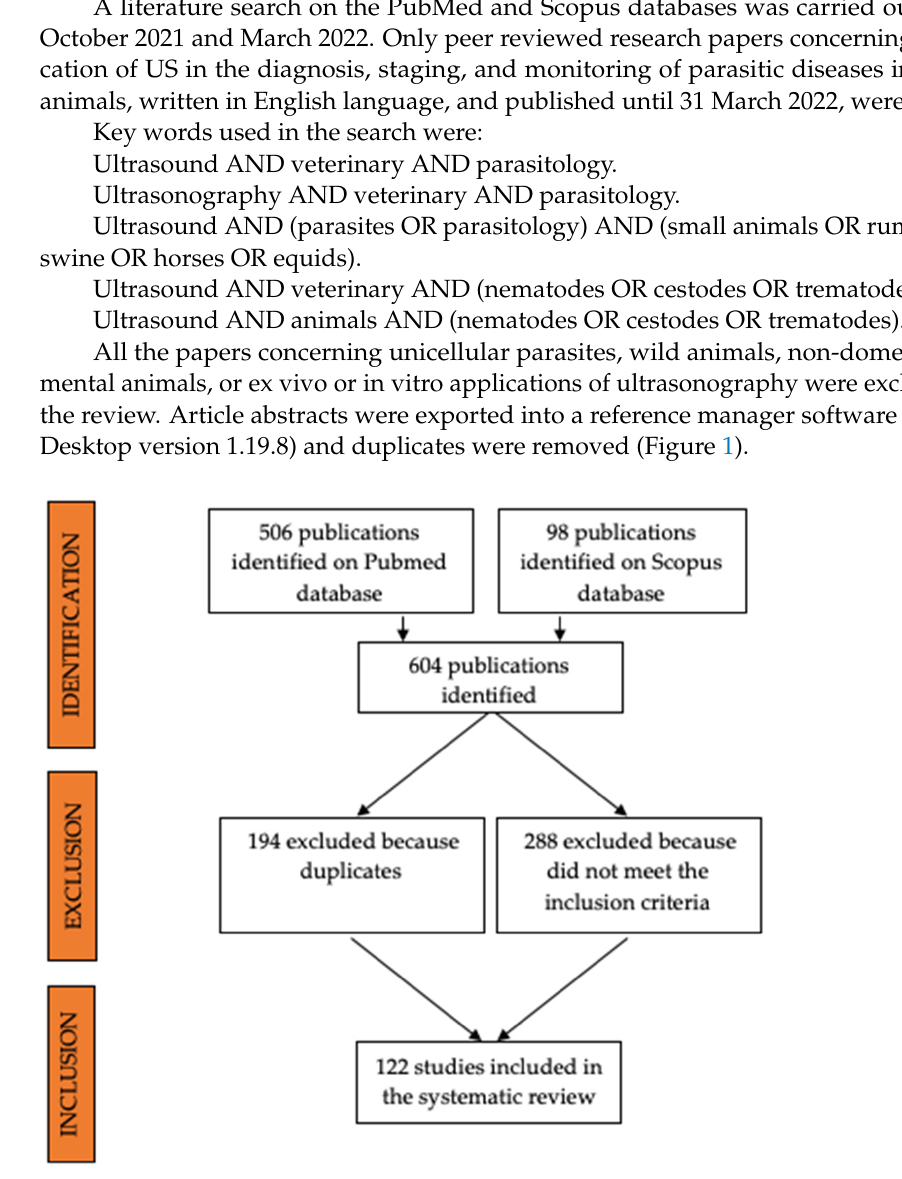
Figure 1. Flow diagram showing the selection process of papers included in this systematic review.